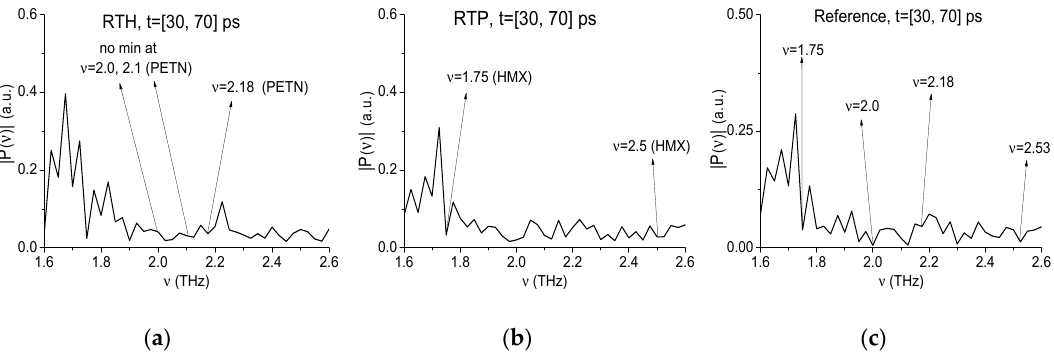
Figure 23. Spectra of the RTH ( a ), RTP ( b ) signals and reference ( c ) computed in the time interval t = [30, 70] ps, in the frequency range ν = [1.6, 2.6] THz.